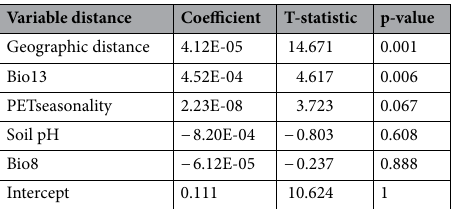
Table 2. Multiple matrix regression with randomization (MMRR) model testing for range wide isolation by distance and isolation by environment for Senegalia